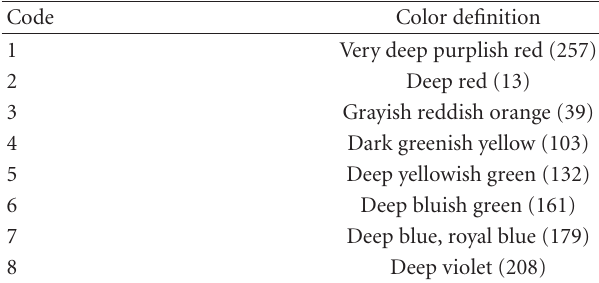
Table 5: Colors used in character analyses (from